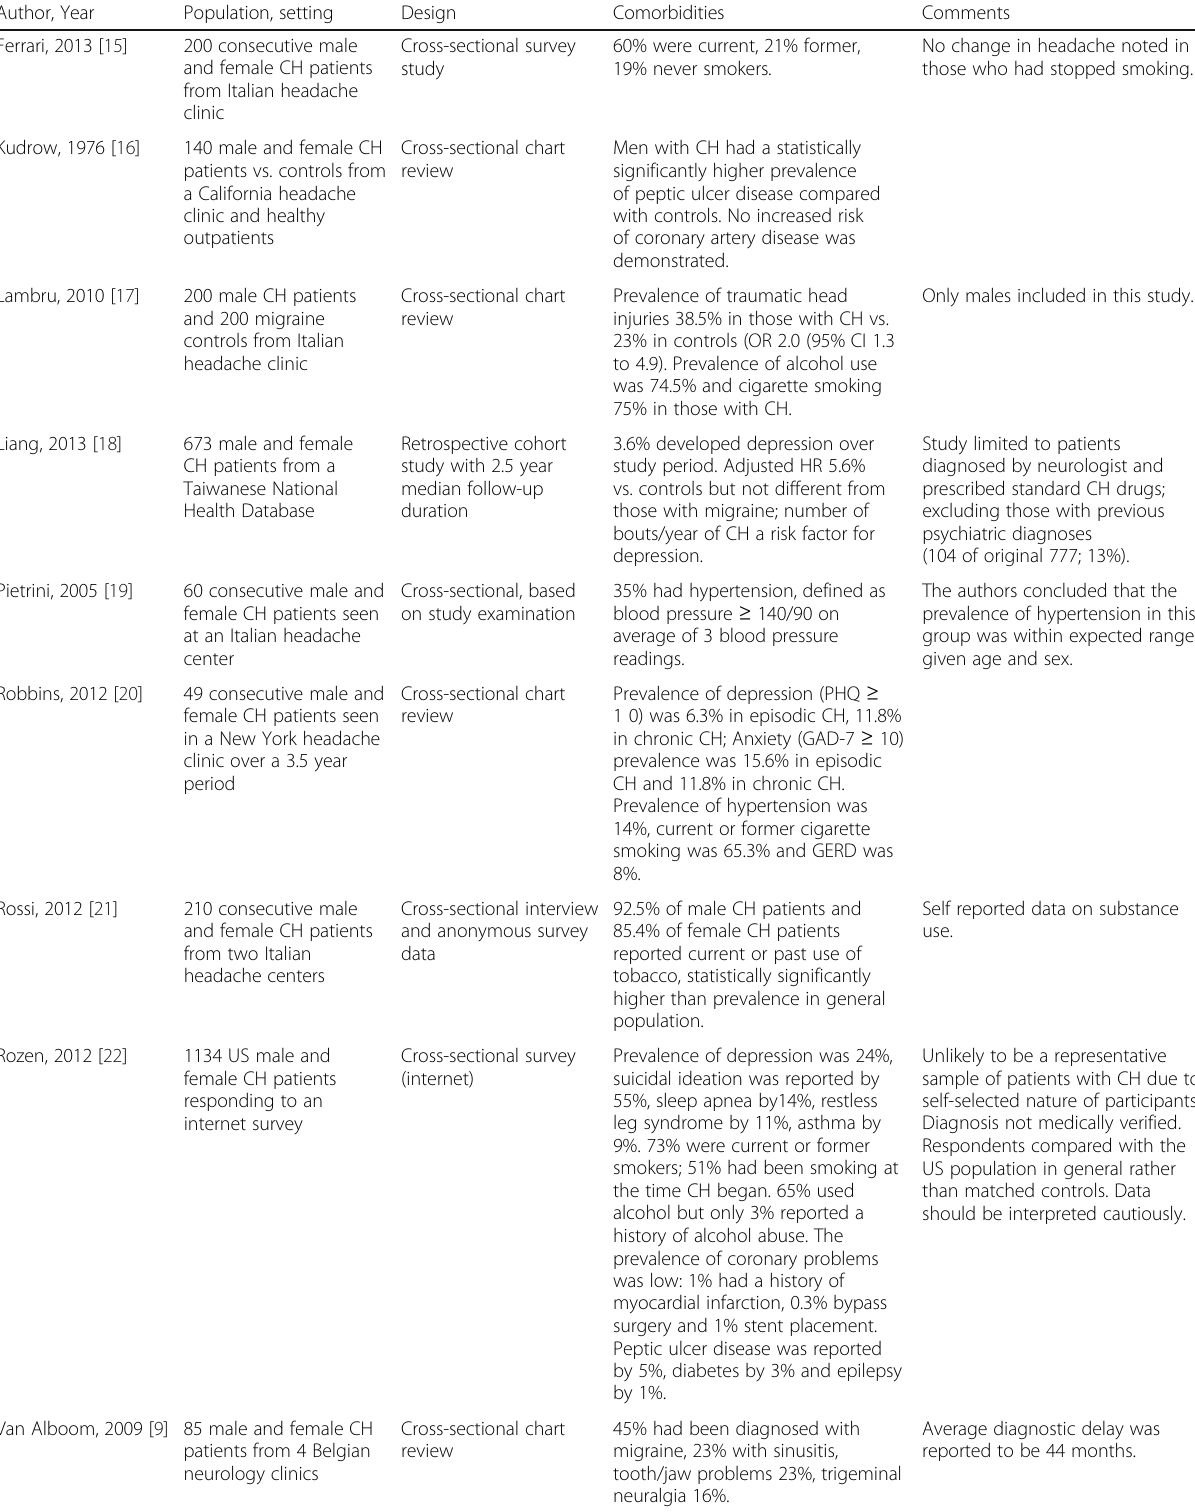
Table 1 Selected previous studies of comorbidity in cluster headache Author,